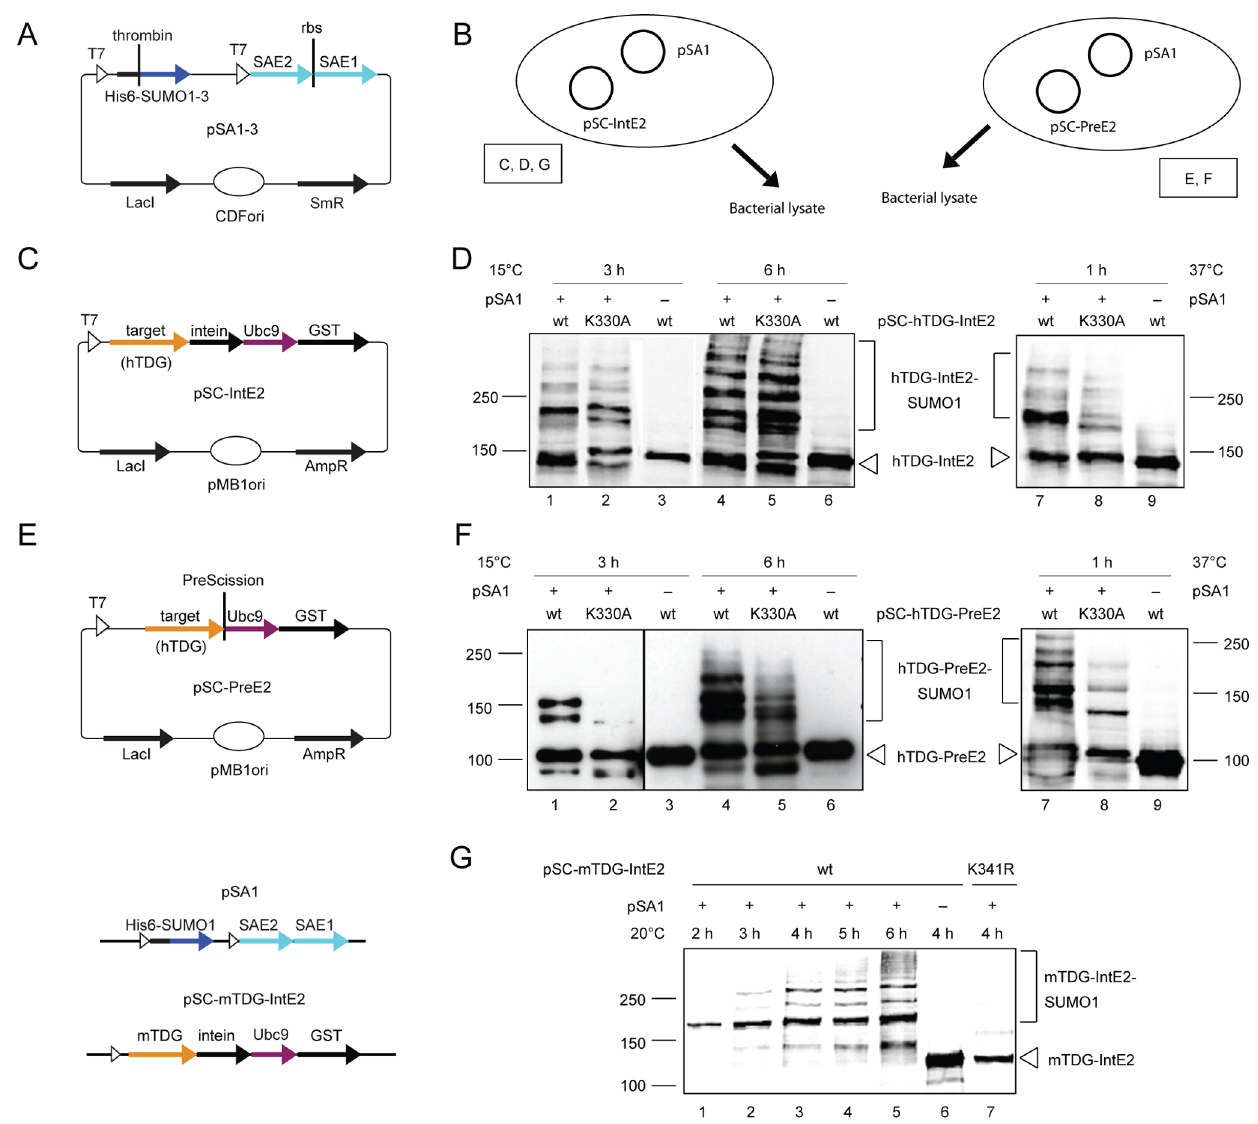
Figure 3. In-cell SUMOylation of TDG with the SUMO-E2-fusion system. Scheme of the SUMO-activating vectors pSA1-3, which are identical to the pSUMO1-3 vectors but lack the Ubc9 expression unit ( A ) and the Ubc9-fusion SUMO-conjugating vectors pSC-PreE2 ( E ) and pSC-IntE2 ( C ) for expression of target protein fused to a GST-tagged Ubc9 under the control of the T7 promoter. A PreScission protease cleavage site or a Mycobacterium xenopi GyrA intein sequence in the linker region allows for the release of the modified target from the Ubc9-GST fusion. ( B ) Experimental setup of in-cell SUMO conjugation with the SUMO-E2-fusion system. pSA1 is co-expressed with target proteins either from pSC-IntE2 or pSC-PreE2 vectors in E.coli BL21. Boxed letters indicate the corresponding sub-panels. Immunoblot analysis of lysates of E.coli cells expressing the SUMO-activating proteins (pSA1) and wild-type (wt) or SUMO acceptor site-mutated (K330A) human TDG (hTDG) from the SUMO-conjugating vectors pSC-IntE2 ( D ) or pSC-PreE2 ( F ). Expression was induced with 250 m M IPTG at 15 u C for 3 and 6 h or with 1 mM IPTG at 37 u C for 1 h. ( G ) SUMOylation of mouse TDG (mTDG) expressed from the pSC-IntE2 vector was followed over time by immunoblot analysis. Expression was induced with 500 m M IPTG and cells were incubated at 20 u C. hTDG-IntE2 and hTDG-PreE2 fusion proteins appeared as a